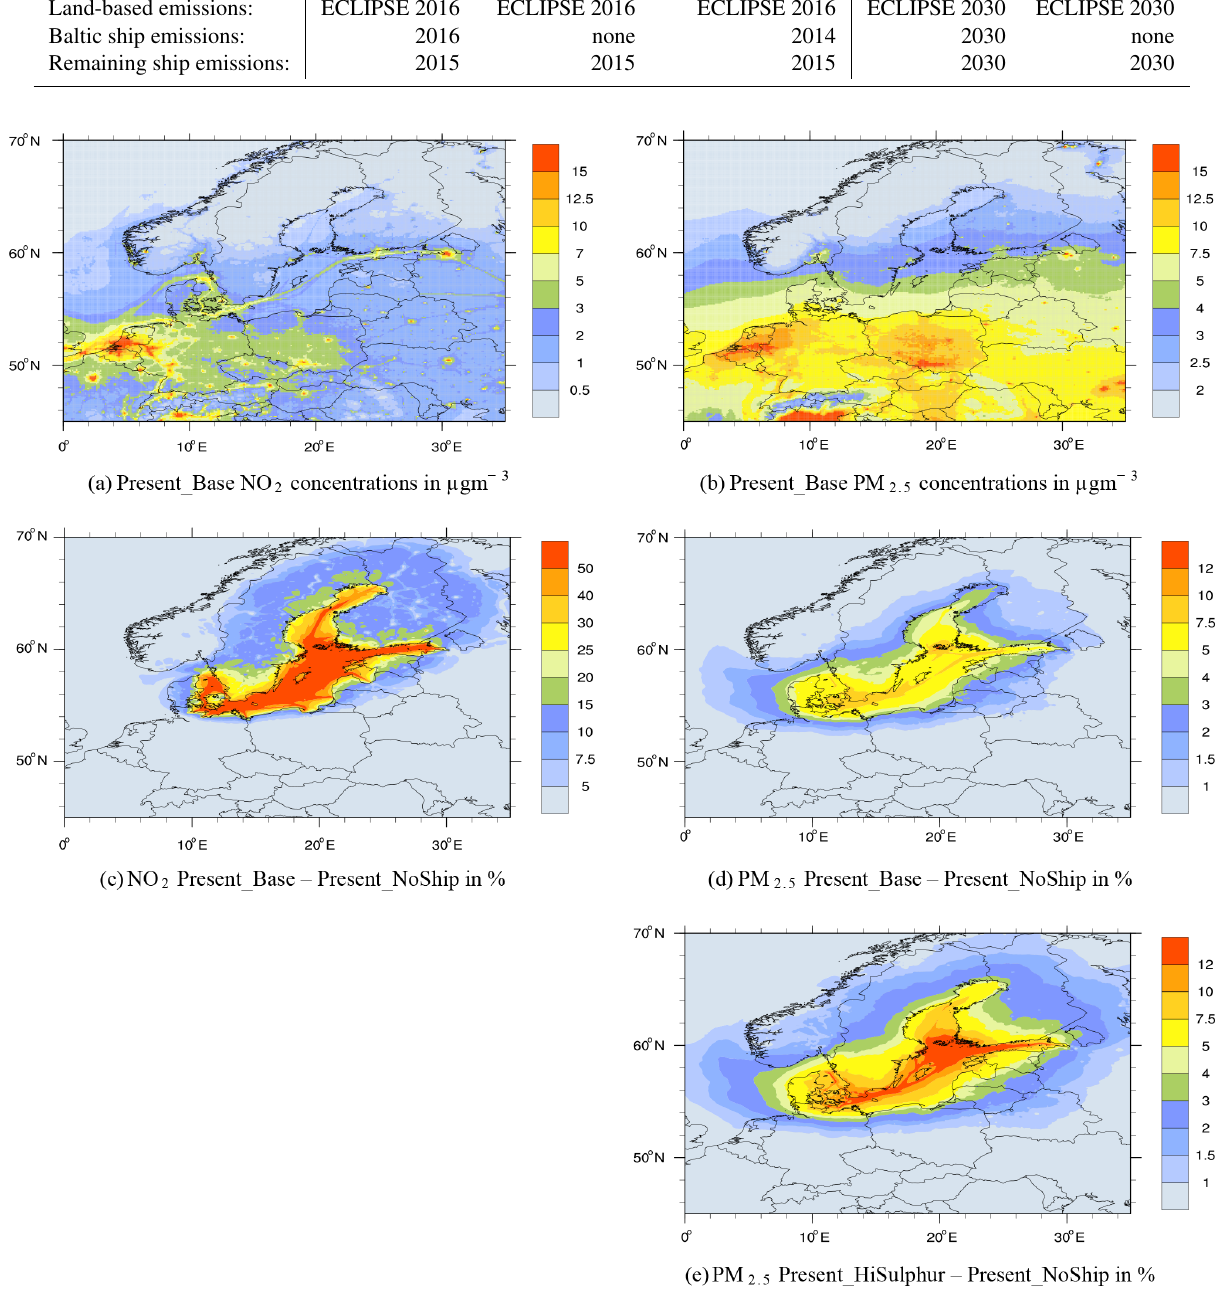
Figure 1. (a, b) Concentrations of NO 2 and PM 2 . 5 in the Present_Base case. (c, d) Present percentage contribution from BAS ship emissions to NO 2 and PM 2 . 5 after the new sulfur regulations. (e) Percentage contribution to PM 2 . 5 concentrations before the new sulfur